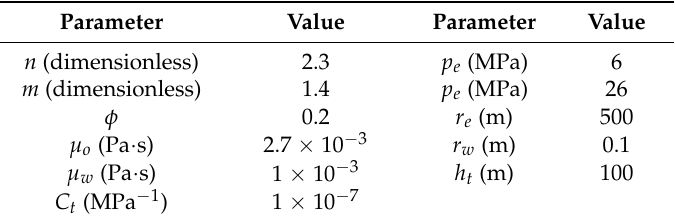
Table 2. Parameter list for